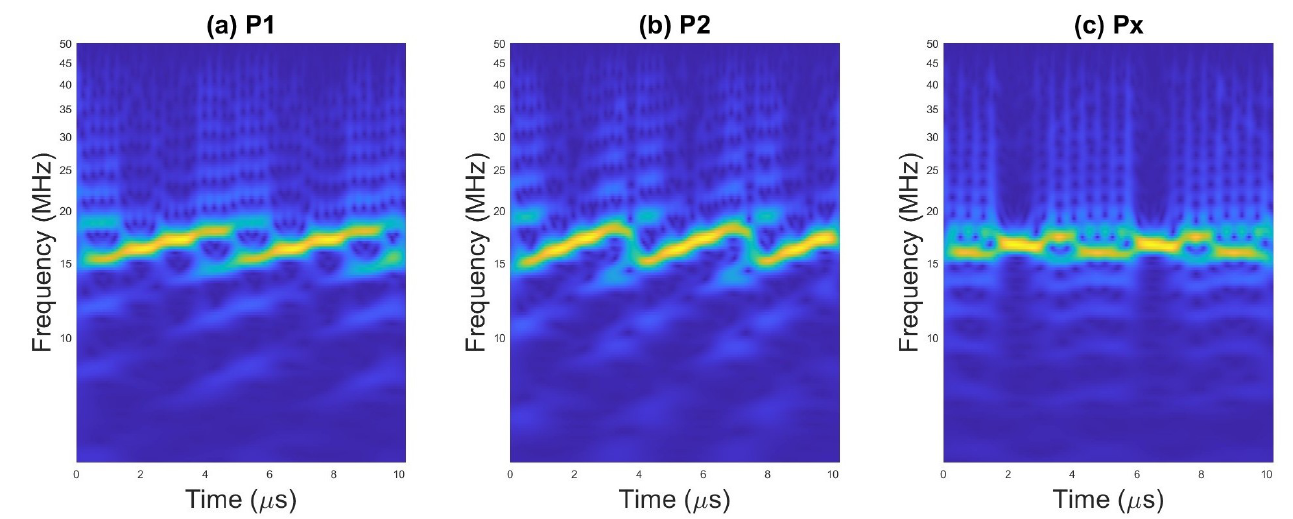
Figure 4. Scalogram for pulses with ( a ) P1 code, ( b ) P2 code, and ( c ) P x